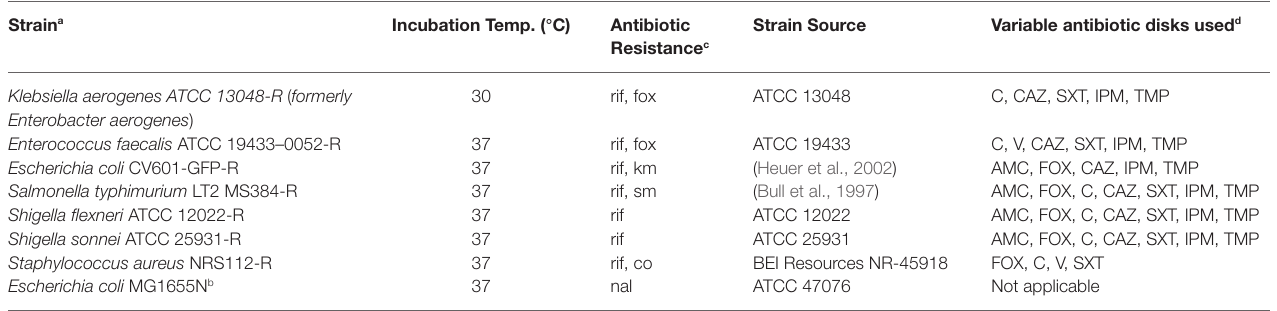
TABLE 1 | Bacterial strains used in this